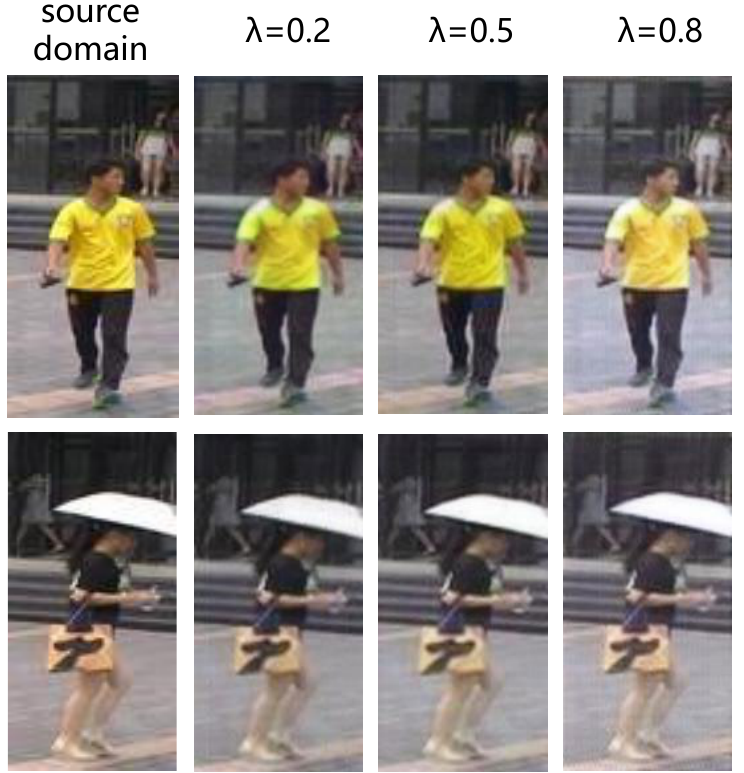
Figure 5. The images of intermediate domains. λ denotes the domainness factor, which decides the style of the images generated by GAN.